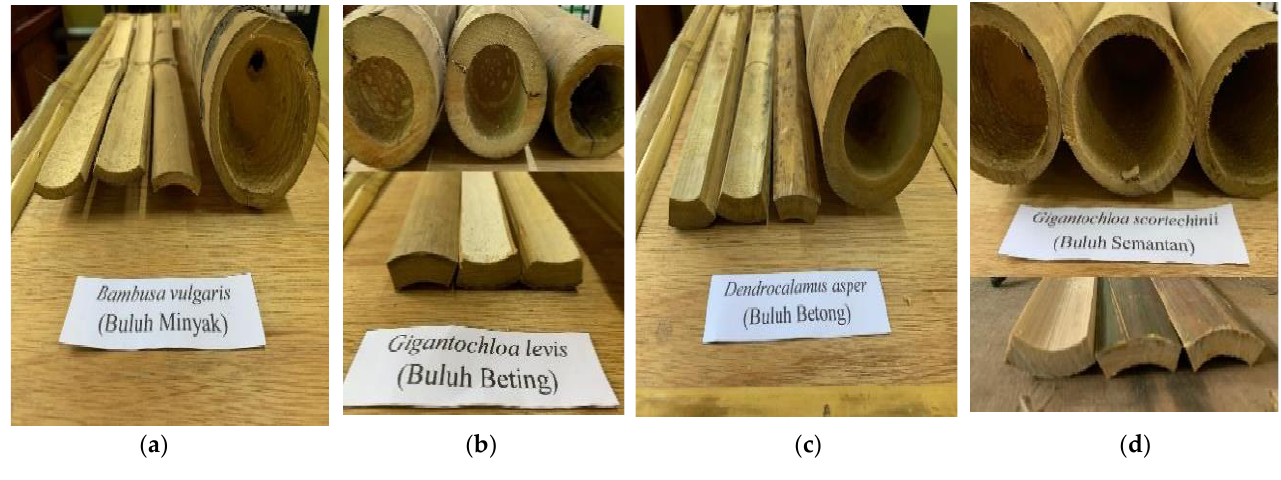
Figure 1. Splits of ( a ) Bambusa vulgaris (buluh minyak), ( b ) Gigantochloa levis (buluh beting), ( c ) Gigantochloa asper (buluh betong), and ( d ) Gigantochloa scortechinii (buluh semantan).